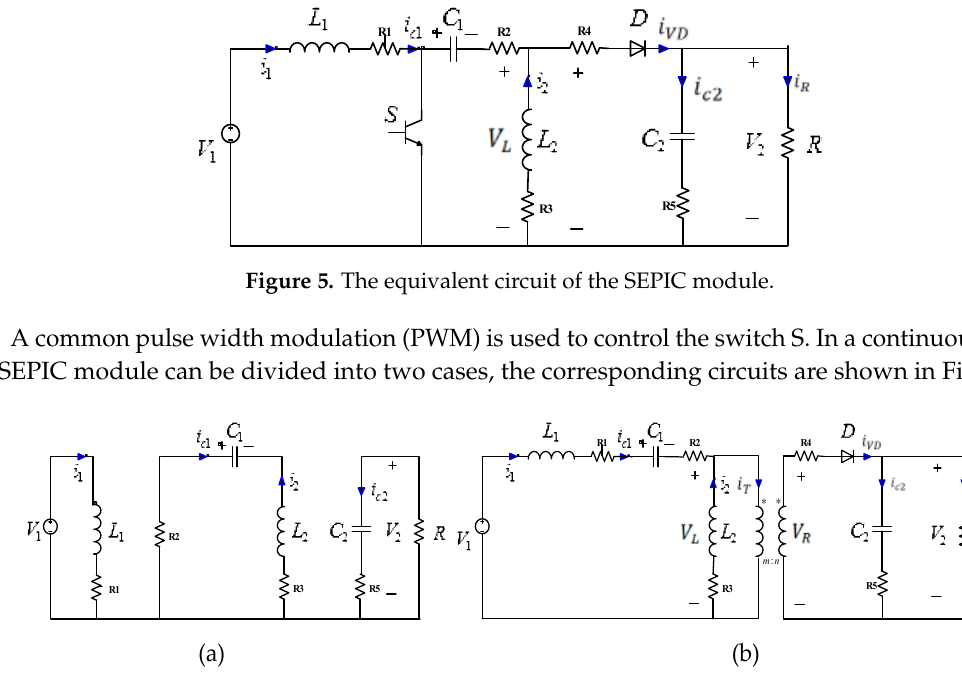
Figure 6. The equivalent circuit of the SEPIC module when the switch is on or off: ( a ) power switch is on; ( b ) power switch is off.